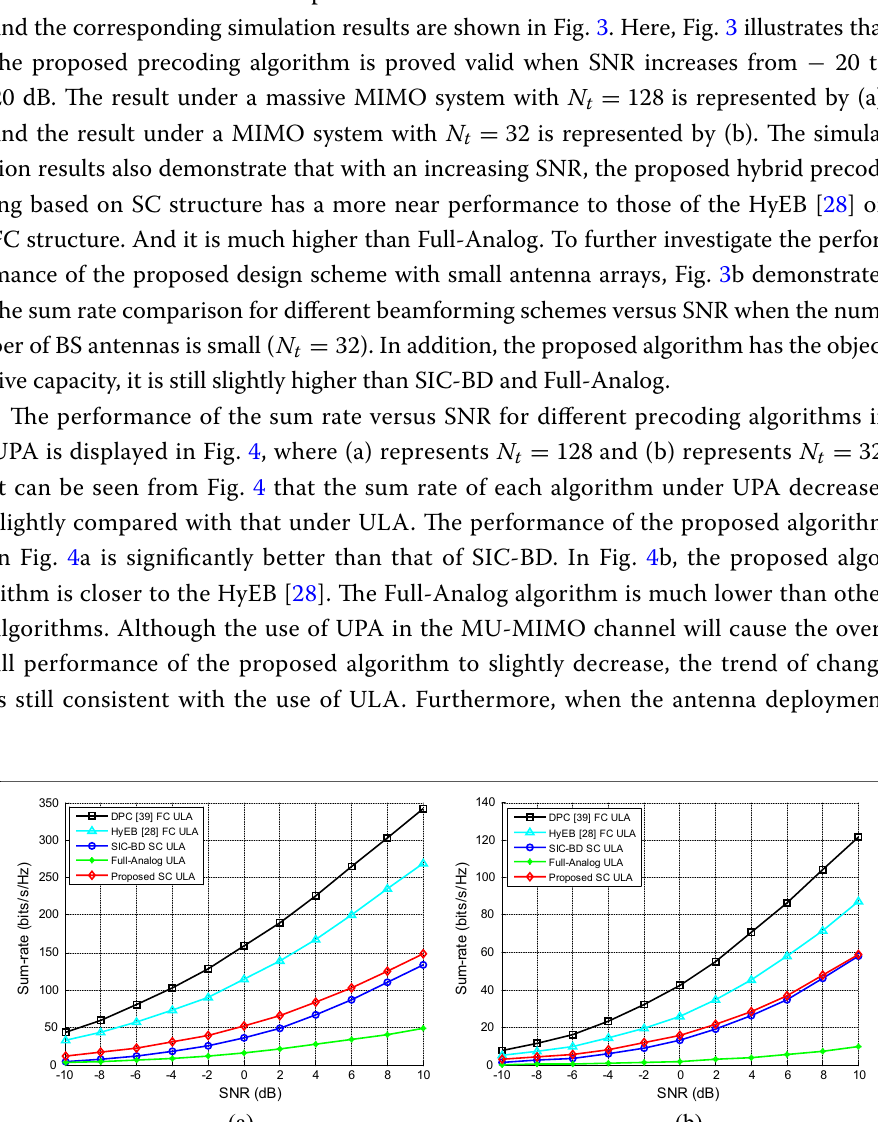
20 to 20 dB. The result under a −